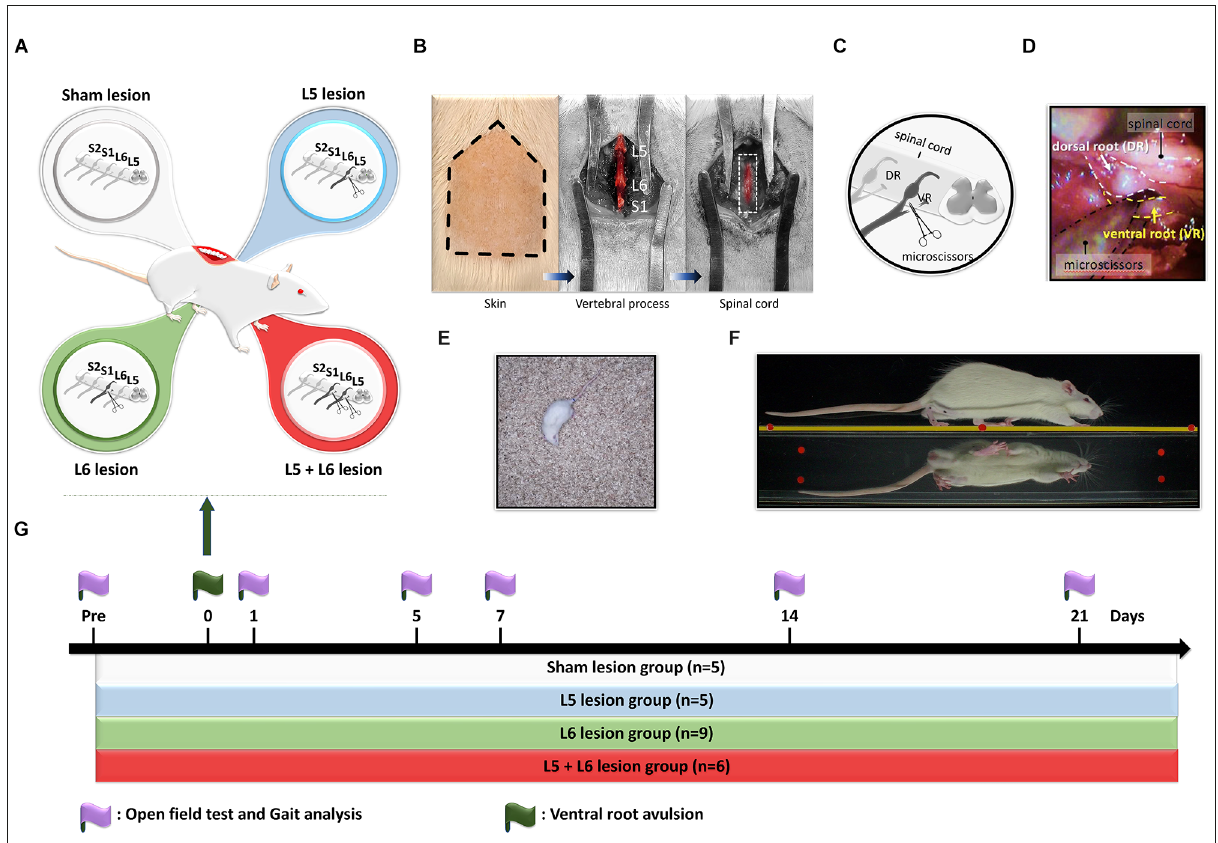
FIGURE1 Design of the study for time-course changes of gait and locomotion functions in ventral root avulsion induced foot drop rat model. (A) Twenty-five rats were divided into four groups, including sham lesions (white), L5 lesions (blue), L6 lesions (green), and L5 + 6 lesions (red). (B) The hair of the lower back region of a rat was shaved for right L5 and L6 ventral root avulsion procedures. Paraspinous muscles and tendons were removed to expose transverse processes of the L5, L6, and S1. Then the L5 and L6 hemilaminectomy was conducted for better exposure of the spinal cord (dash line square) and the right ventral roots. (C) A schematic representation of the surgical ventral root avulsion model indicating the rhizotomy of the L5-L6 ventral roots. (D) The ventral root was grabbed with fine forceps and transected 3–4 mm proximal to the dorsal root ganglion with microscissors. (E) The locomotor function was assessed by the open field test in rats. (F) The gait pattern was evaluated by the transparent walking track. (G) Experimental design for time-course behavioral assays following ventral root avulsion in rats. Two behavioral tests, including an open field test and gait analysis, were performed pre-procedure and on days 1, 5, 7, 14, and 21 post-avulsions to investigate the changes in the gait parameters over